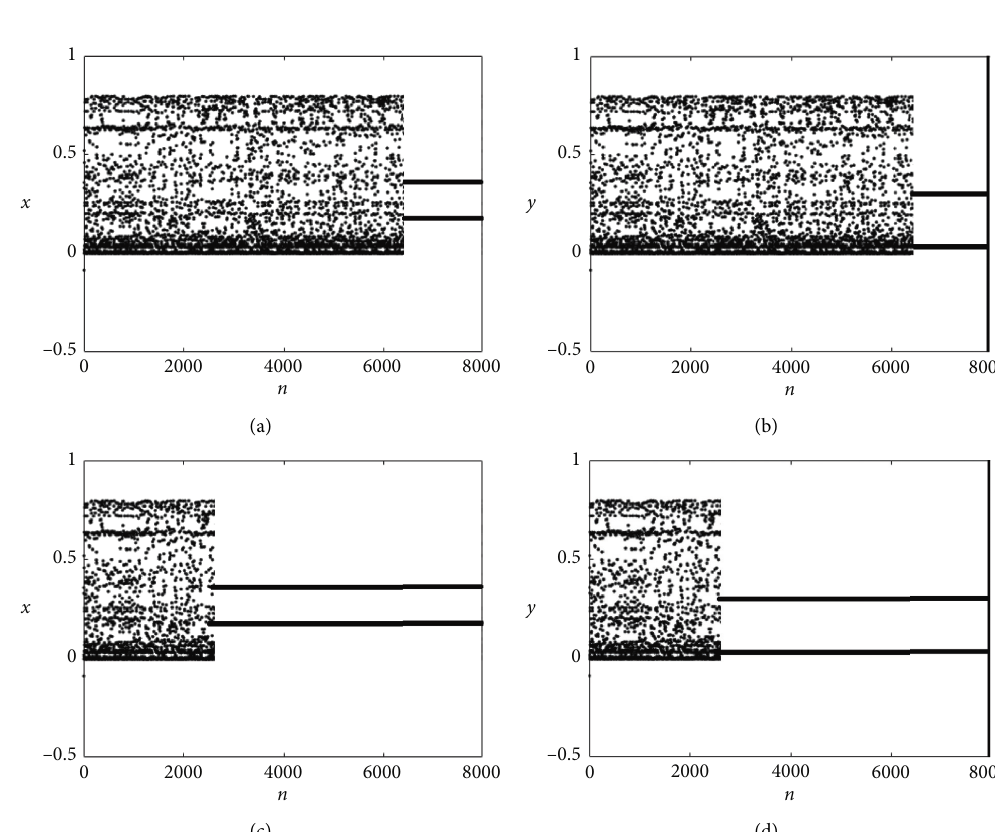
Figure 6: Control of period-2 of Hassell